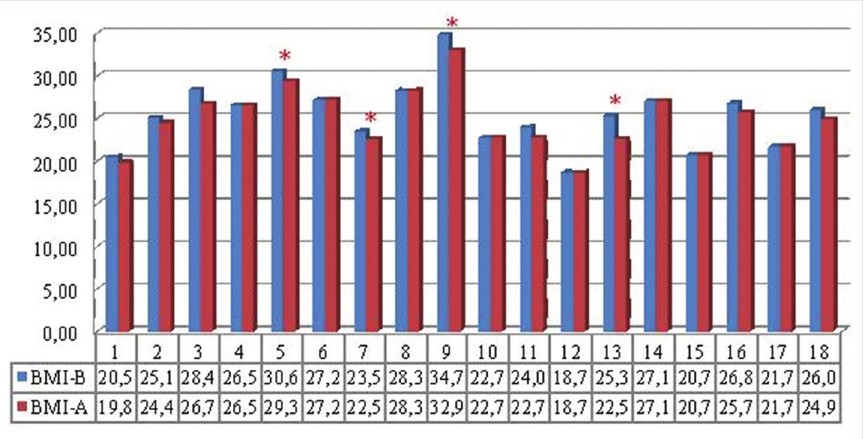
FIGURE 1. Body mass index (BMI) values before and after the 12‑month program (*individuals who dropped to a lower BMI